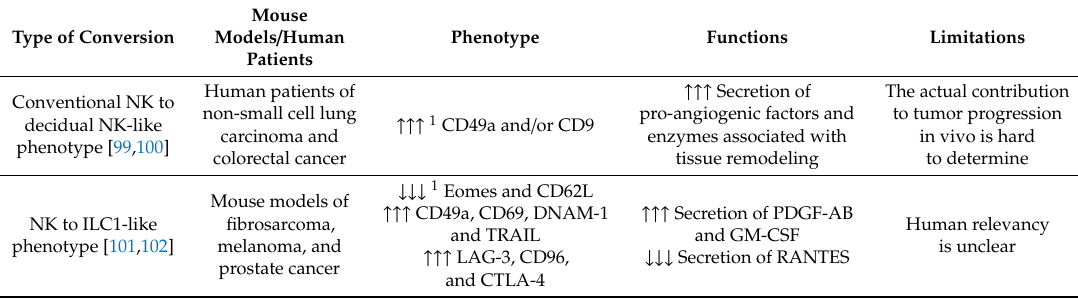
Table 1. Pro-tumor conversions of natural killers